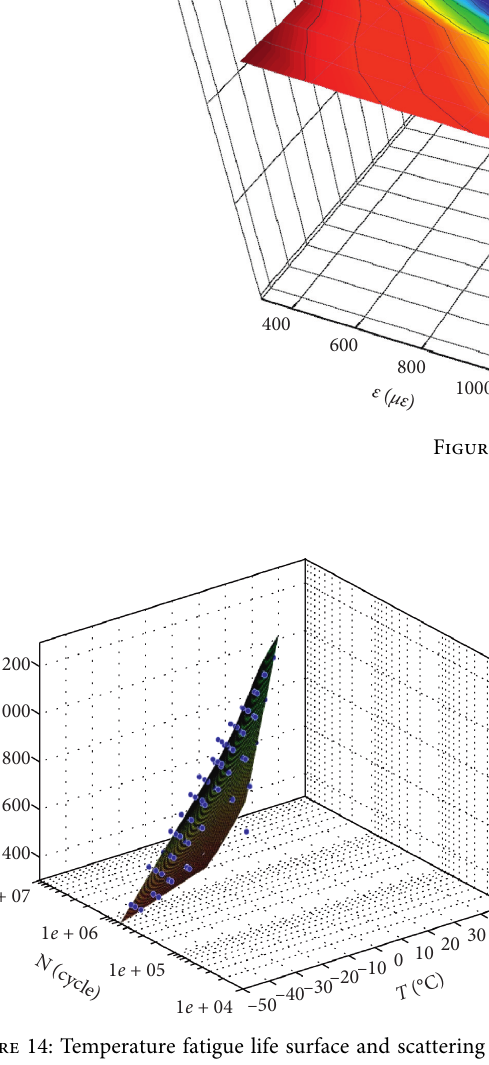
Figure 15: Effect of temperature on strain fatigue limit of poly- urethane